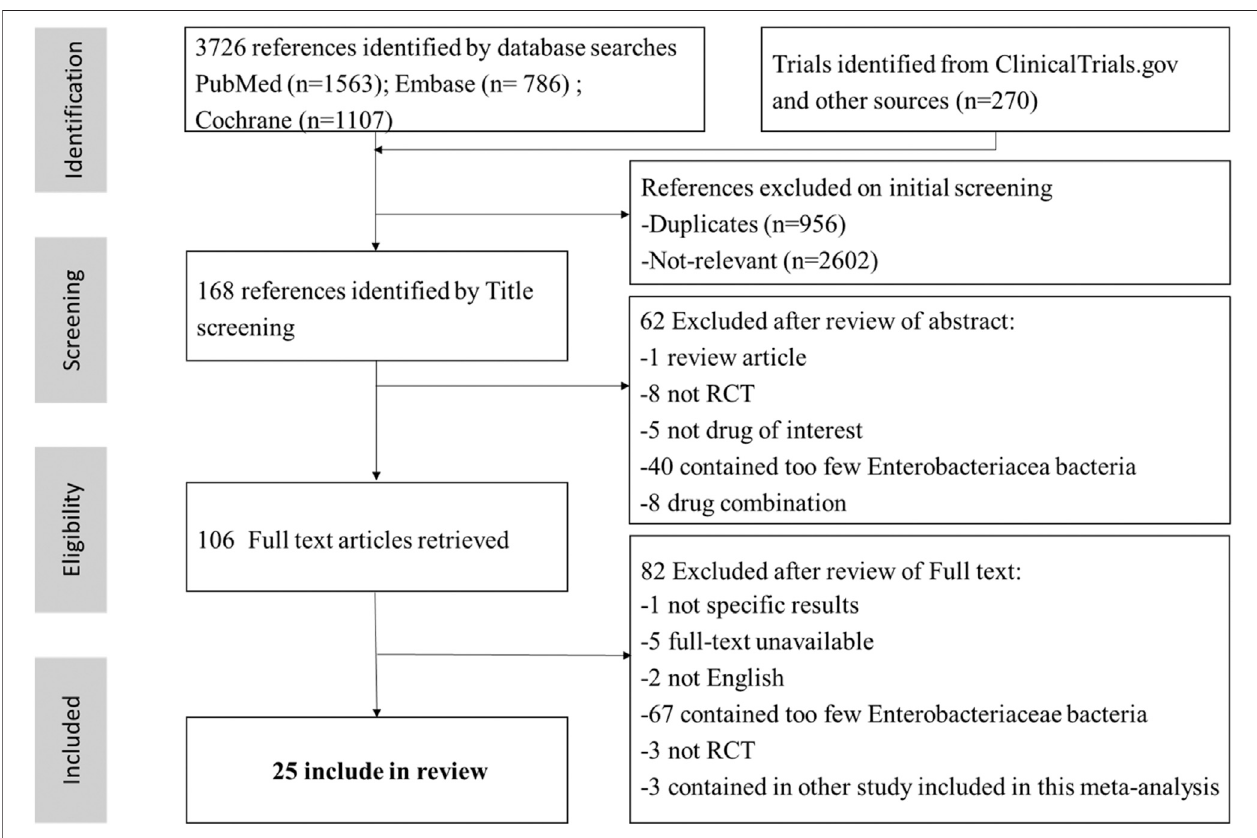
FIGURE 1 | Study selection flow diagram.